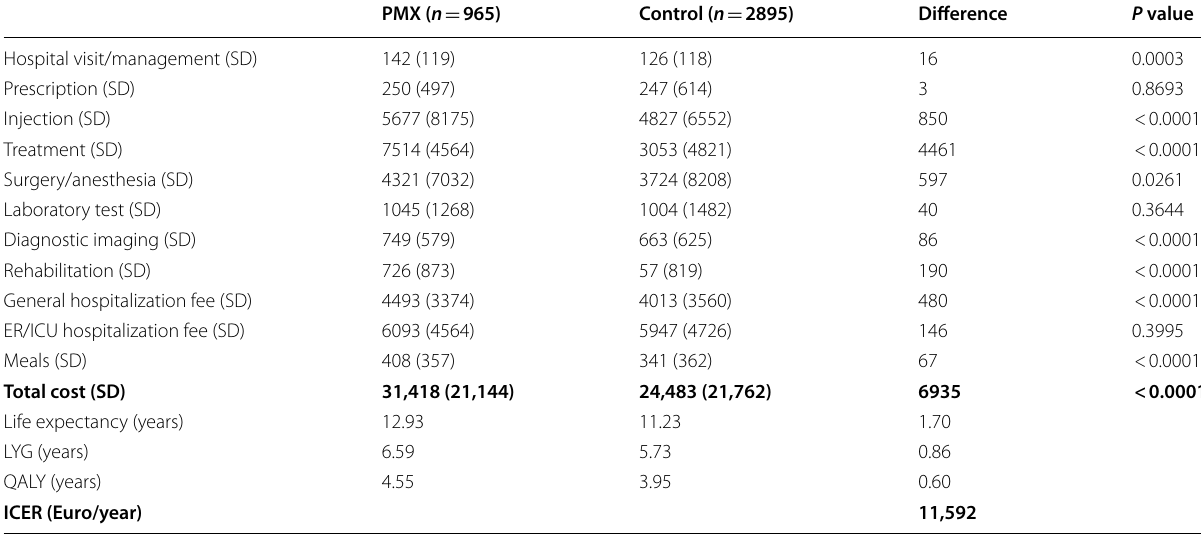
Table 3 Cost and clinical